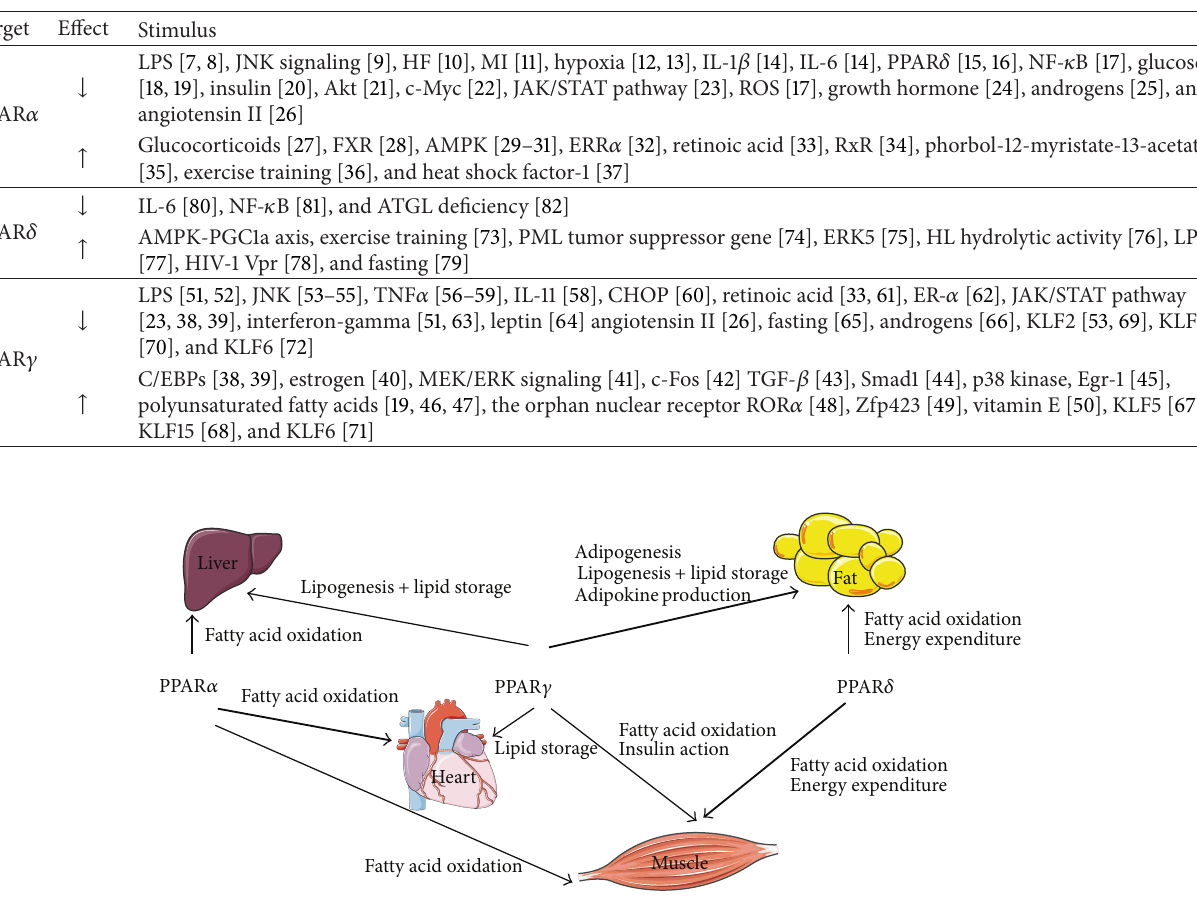
as glucocorticoids [27], farnesoid X receptor (FXR)